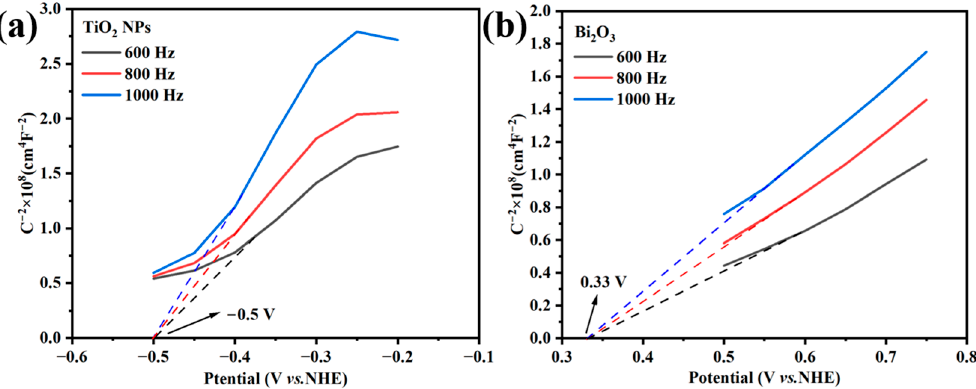
Figure 11. Mott–Schottky plots of ( a ) TiO 2 NPs and ( b ) Bi 2 O 3 . Figure 12a,b shows the results from the free radical trapping experiments of